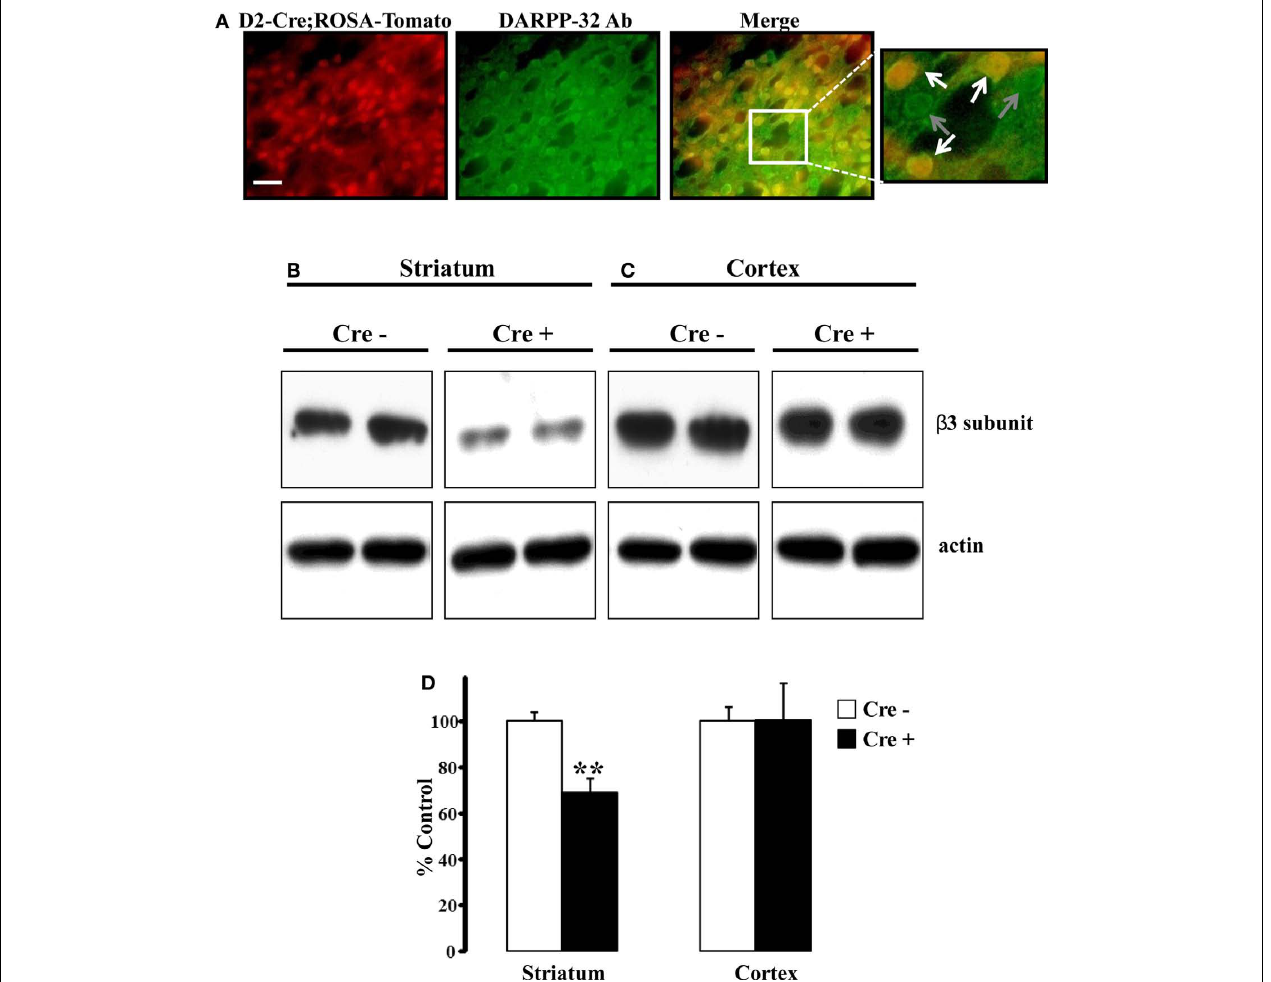
Cre positive ( β 3f/f Drd2 ) animals compared to Cre negative ( β 3f/ + and β 3f/f) control animals.The amount of β 3 protein in cortex (C) did not differ between genotypes. Blots were reprobed for β -actin. (D) Summary graph of western blot analysis demonstrating a significant reduction in β 3 protein in striatum, but not cortex. Data are expressed as percent change in band intensity relative to Cre negative controls following normalization to